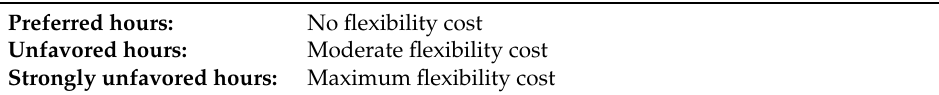
Table 2. Classification of operating times and their flexibility